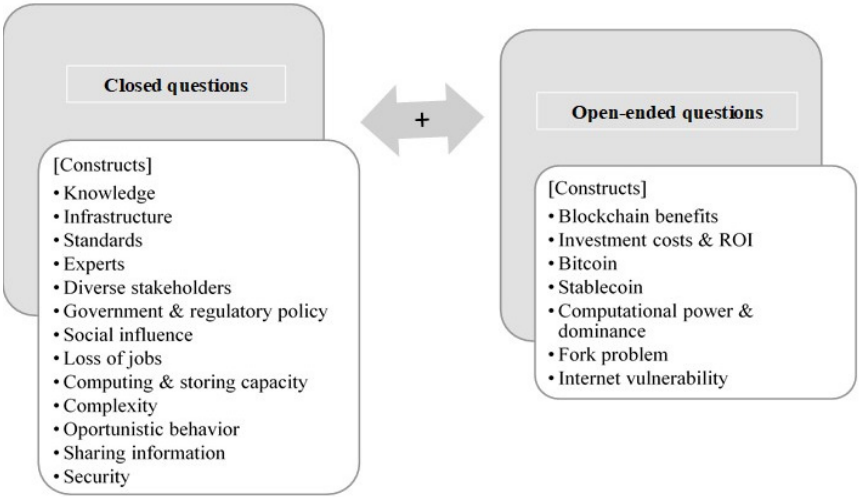
Figure 1. Survey structure and key constructs (Source: Own).